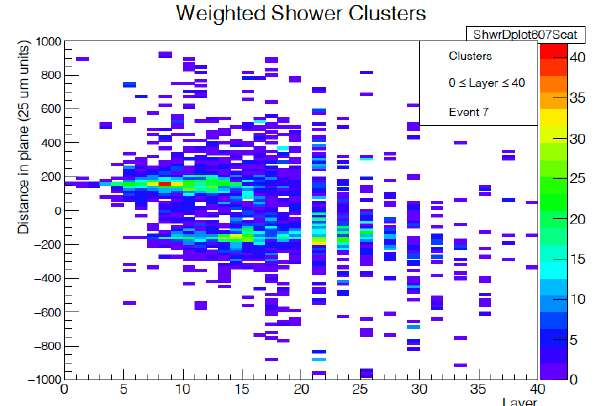
Figure 4. Transverse distribution of two 10 GeV showers separated by one cm. LEFT: Pixel amplitudes in the ILC 13 mm 2 TDR pixel design. RIGHT: Clusters in the first 5.4 radiation lengths in the new SiD digital MAPS design based on a G EANT 4 simulation.